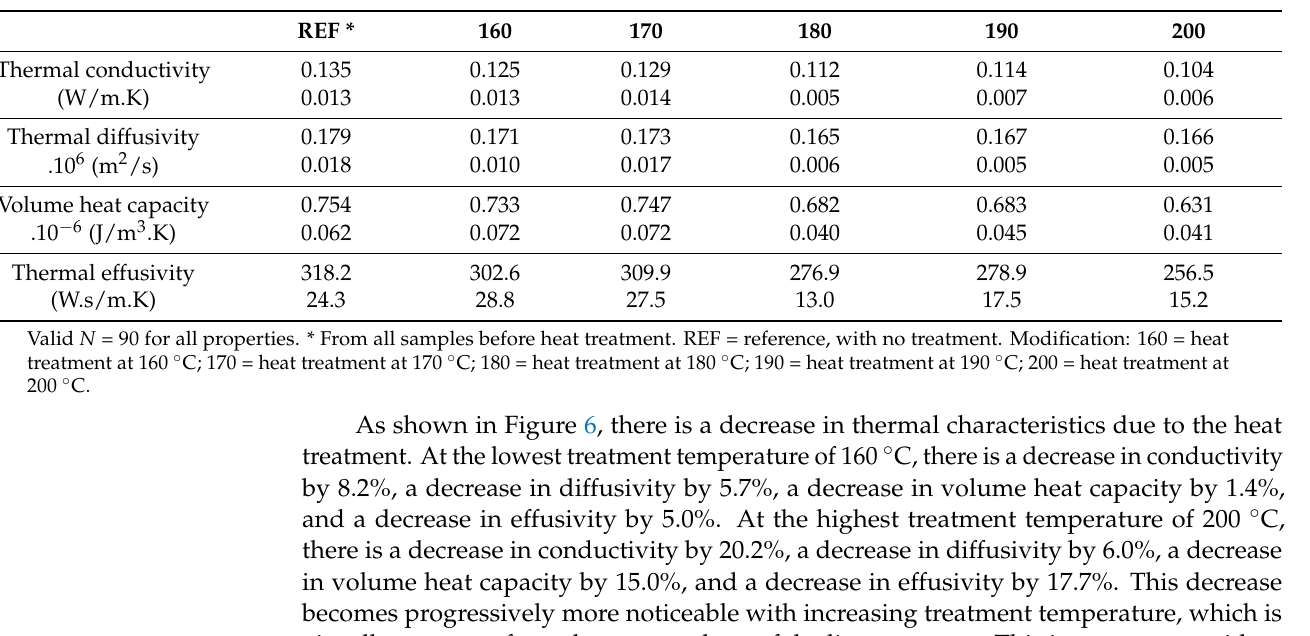
Table 1. Descriptive statistics (Mean value and Standard deviation) of thermal characteristics for unmodified birch wood and individual stages of heat-treated birch wood; including